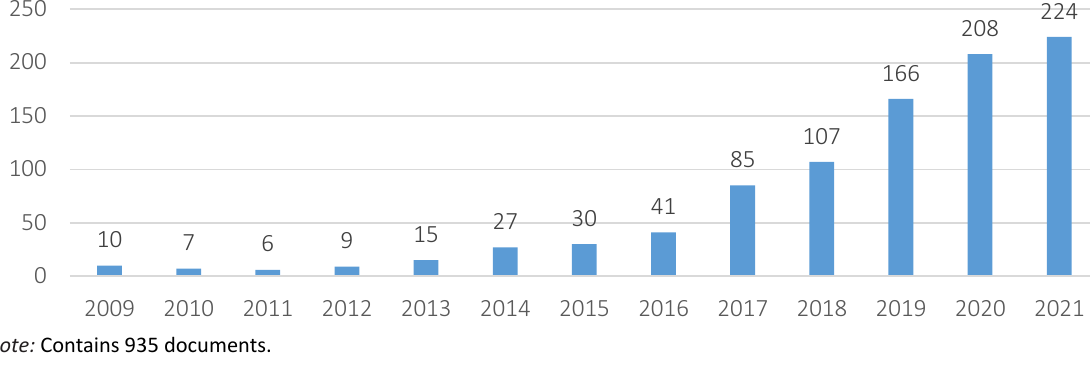
Figure 2. Number of publications (2009–2021) forming the studies’ sample